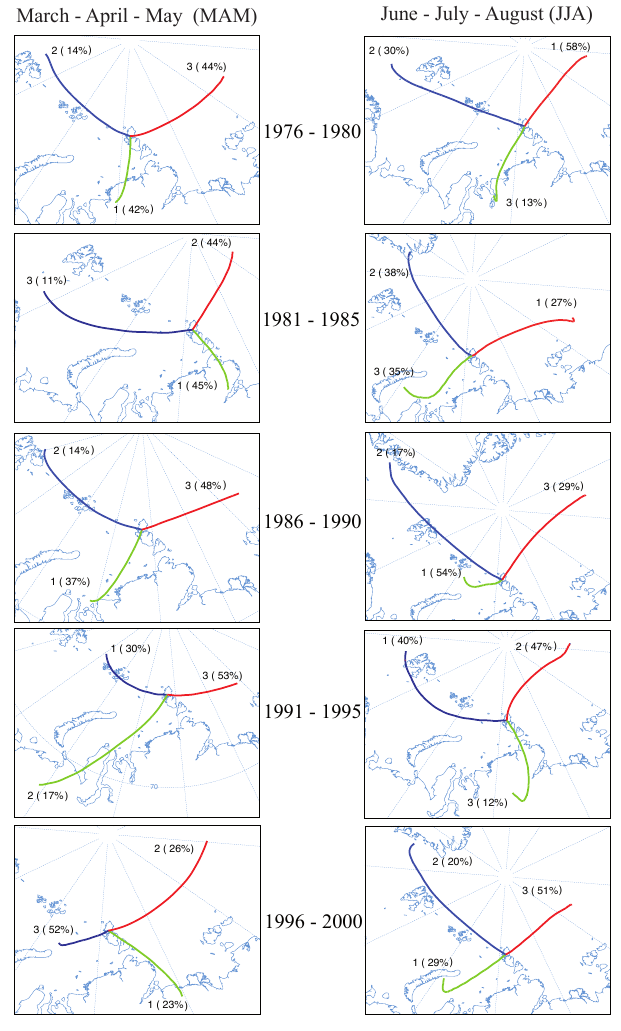
Figure 2. Air mass back trajectories calculated for the period 1976– 2000. Each panel represents the 5-year average for spring (MAM, left column) and summer (JJA, right column)